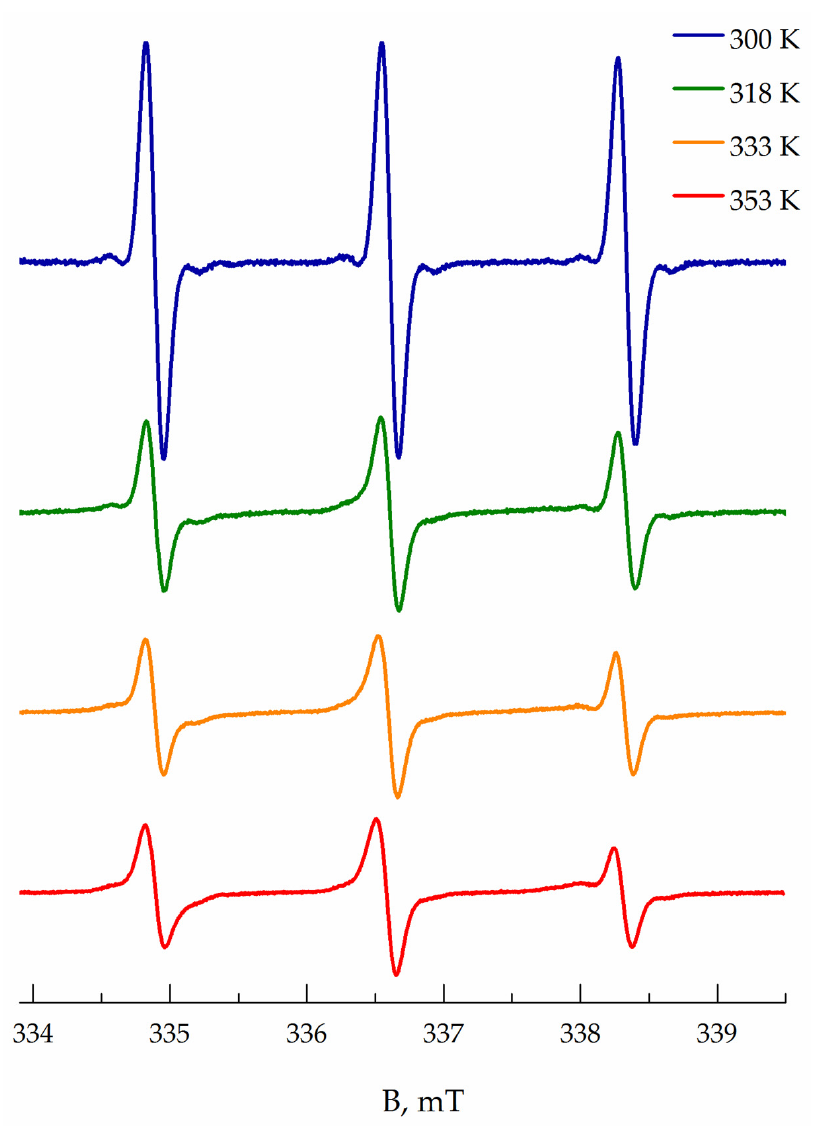
Figure 1. Normalized EPR spectra of TEMPO radical in 10 wt% PNIPAM aqueous solutions at 300–353 K registered upon heating.